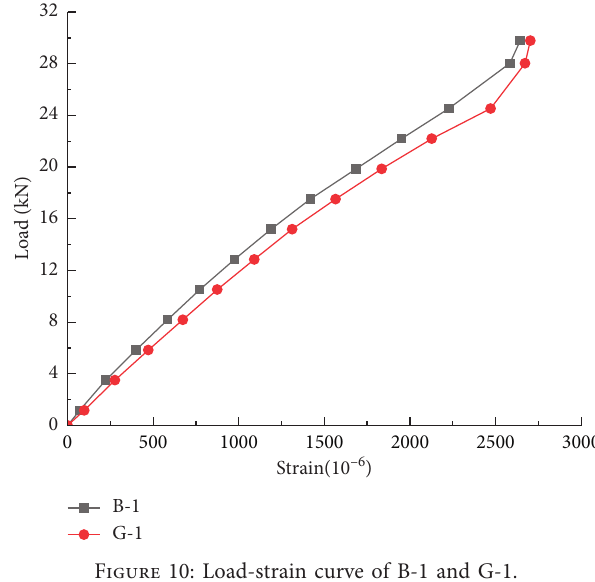
Figure 10: Load-strain curve of B-1 and G-1.